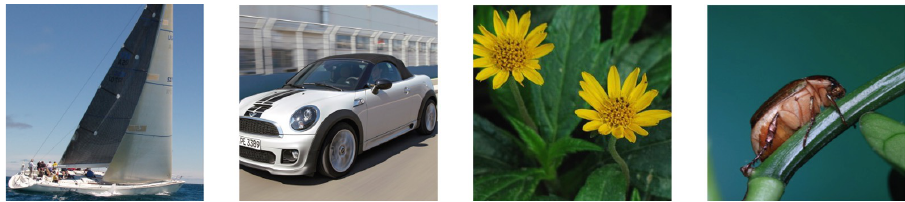
Figure 5. Sample from the GHIM10K dataset. From left to right: Boats, Cars, Flowers,